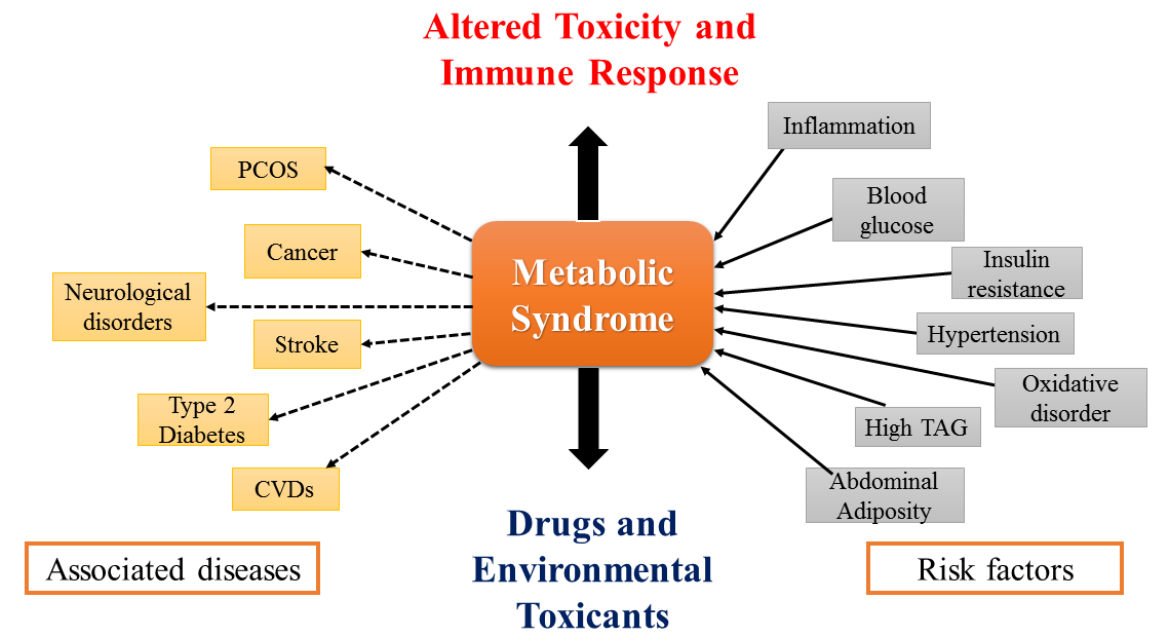
Figure 1. Risk factors of MS and its associated